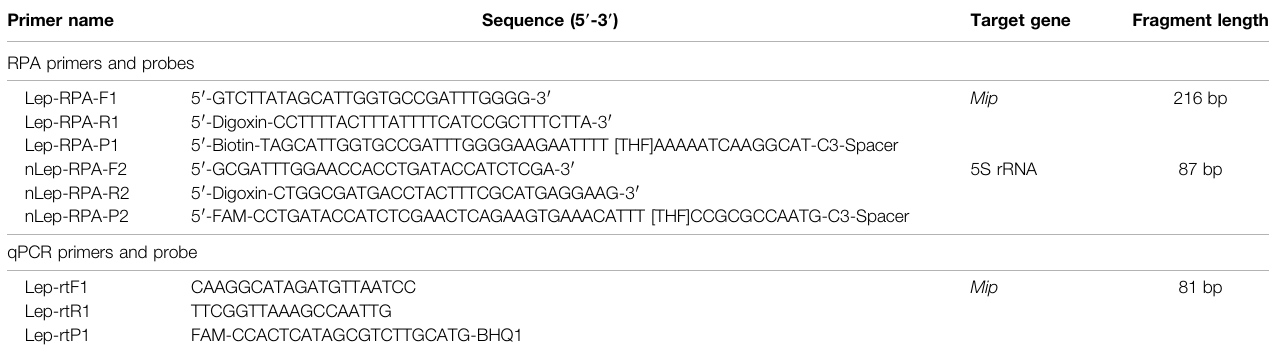
TABLE 2 | Sequences of Legionella for RPA and qPCR